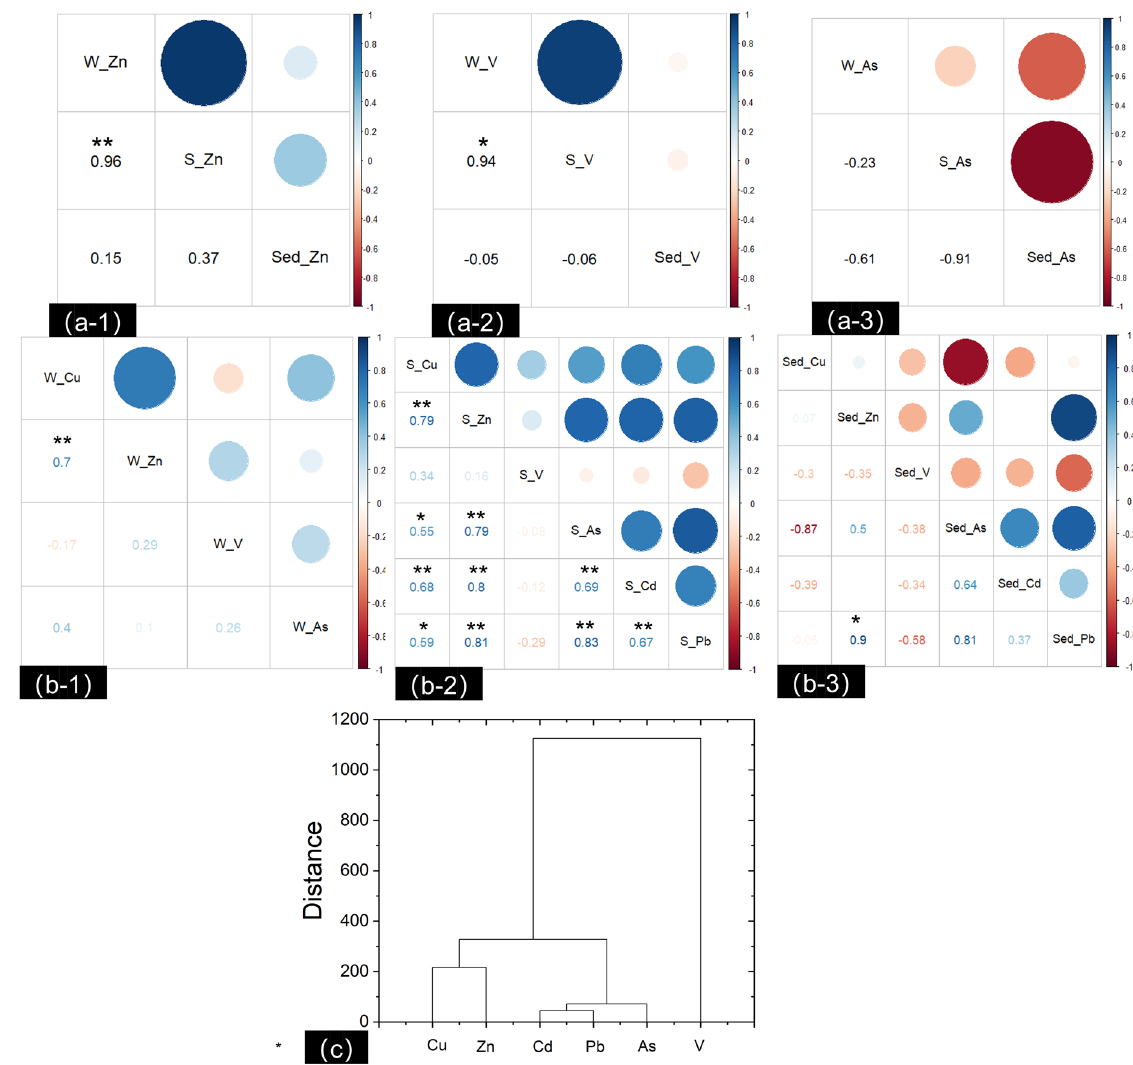
Figure 5. Correlations of Zn ( a-1 ), V ( a-2 ), and As ( a-3 ) in multiple compartments and of REs in surface water ( b-1 ), riparian soil ( b-2 ), and sediment ( b-3 ); cluster analysis of HM species in sediment ( c ). **Significant correlation at the 0.01 level (2-tailed). *Significant correlation at the 0.05 level (2-tailed). W_Zn, S_Zn, and Sed_Zn represent the concentrations of Zn in the surface water, riparian soil, and sediment,